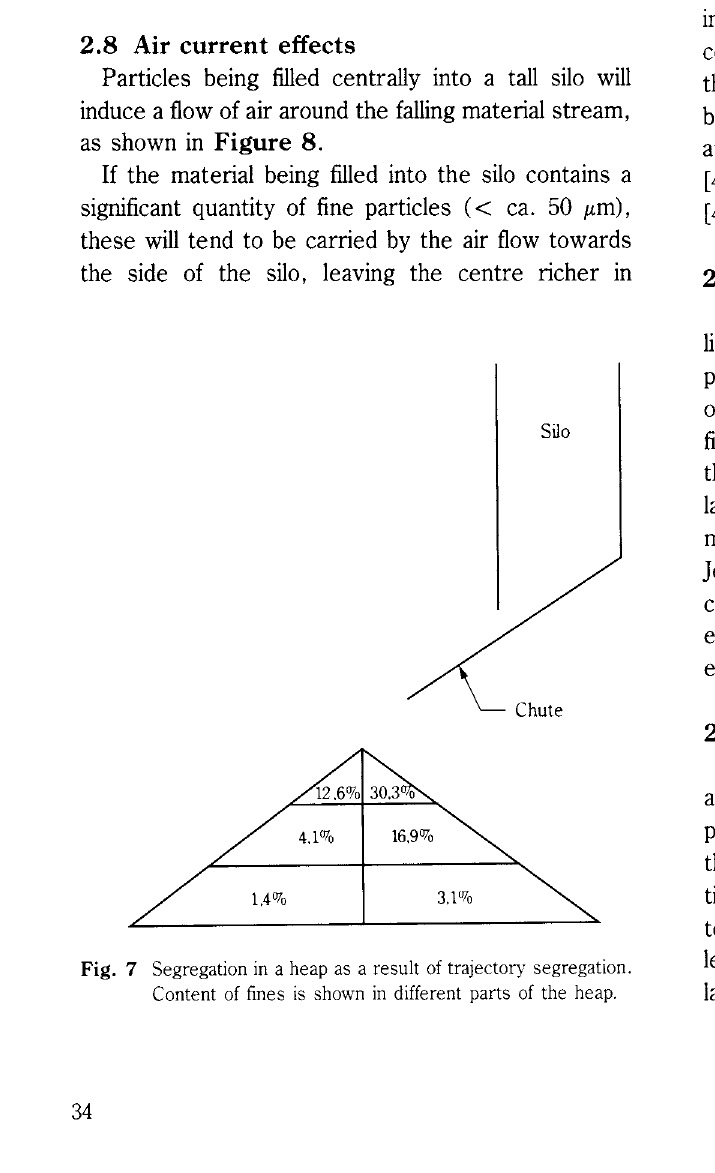
Fig. 8 Air currents set up during the filling of a